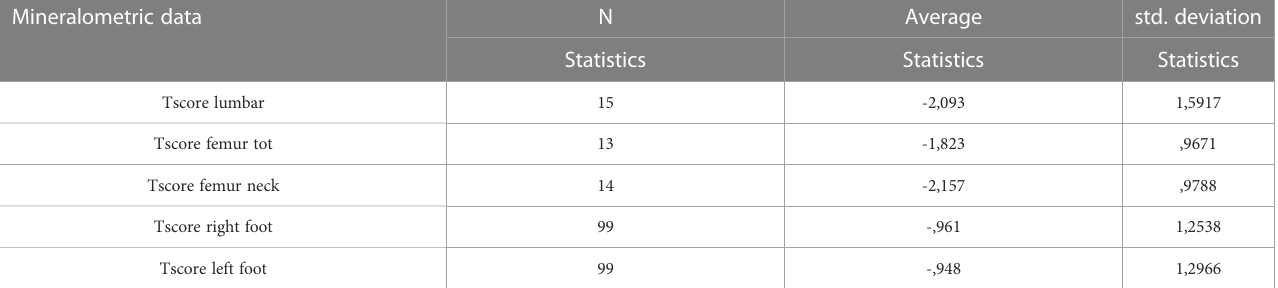
TABLE 2 Mineralometric data. Mineralometric data